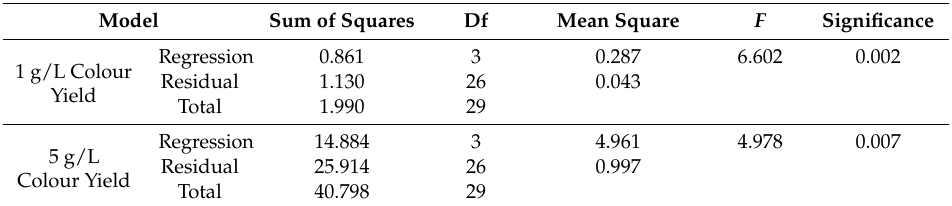
Table 8. ANOVA table of colour yield regression model.